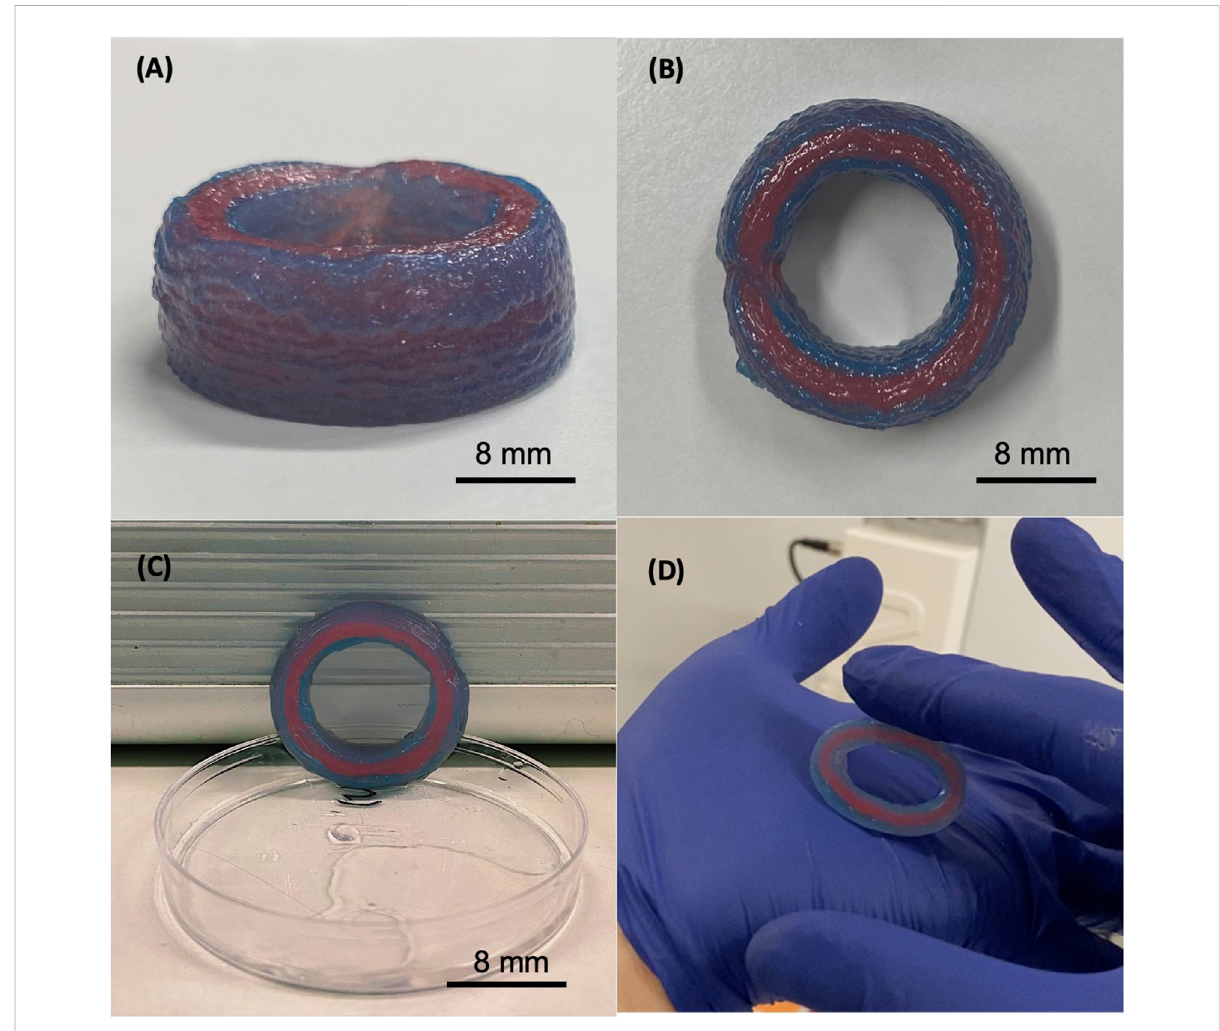
FIGURE 6 The3Dbioprintedconstructcomposedby8%w/vgelatin,7%w/valginate,and3%w/vdECM.Printingsettings:pressure=100 kPaandvelocity 20 mm/s. The height of the produced sample is 9 mm (A) , the internal diameter is 17 mm and its thickness is 4 mm (B) . The construct maintains the shape and does not collapse under its weight (C) , and it results elastic and stable in the handling and under cycle stress applied manually (D)